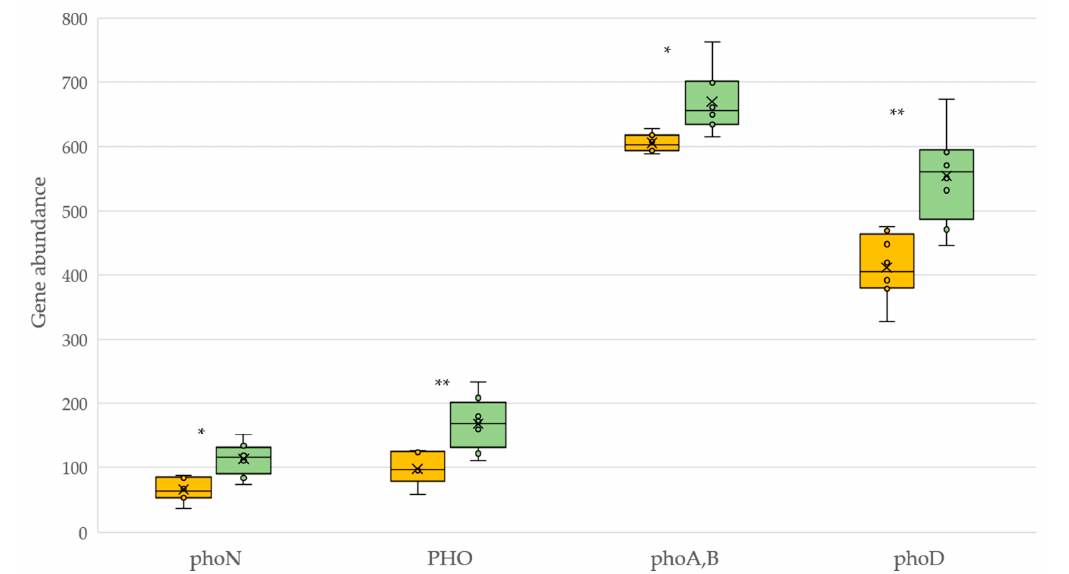
pH of catalysis, 6 in the former and above 7.5 in the latter.